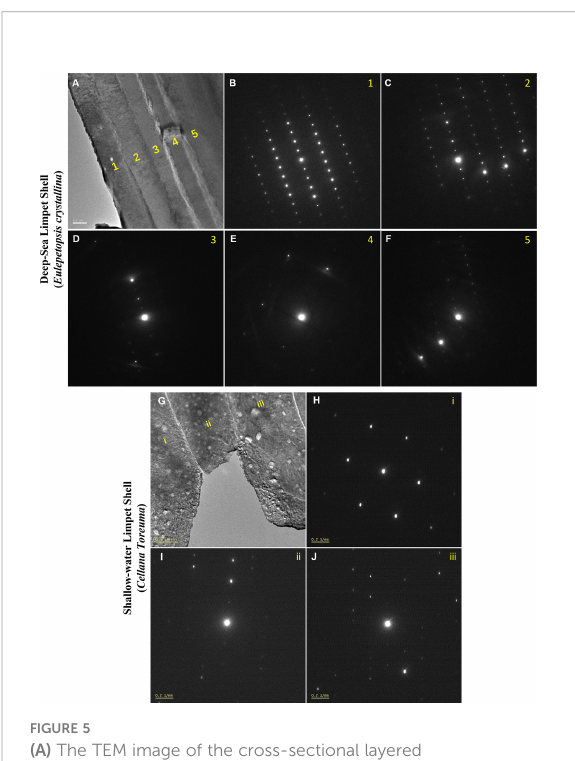
FIGURE 5 (A) The TEM image of the cross-sectional layered microstructures of deep-sea limpet E. crystallina shell. (B – F) Selected-area electron diffraction (SAED) patterns of the corresponding numbered layers 1 – 5 of deep-sea limpet E. crystallina shell in panel (A) . (G) The TEM image of the cross- sectional layered microstructures of shallow-water limpet C. toreuma shell. (H – J) SAED patterns of the corresponding numbered layers i – iii of shallow-water limpet C. toreuma shells in panel (G)